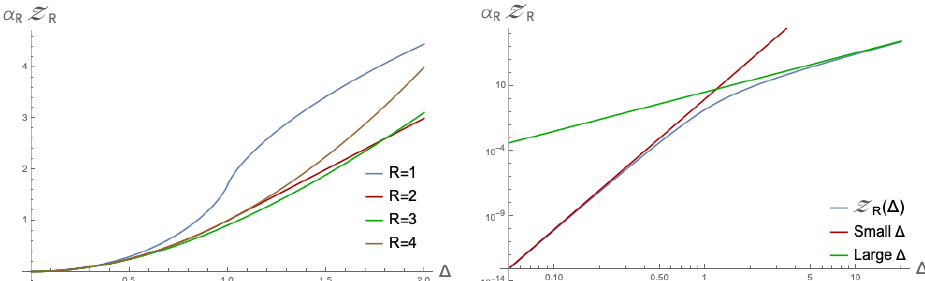
Figure 1. On the left : Z R ( ∆ ) for symmetric tensors with ∆ running from ∆ = 0 to 2, where K = 3, N = 2, and w = 1. On the right : The limiting behaviour of Z R ( ∆ ) for K = 3, N = 4, w = 2, R = 3, again for symmetric tensors. The blue curve represents (22), the red line the small ∆ behaviour of (23), and the green line the large ∆ behaviour of (24). α R ≡ a normalisation